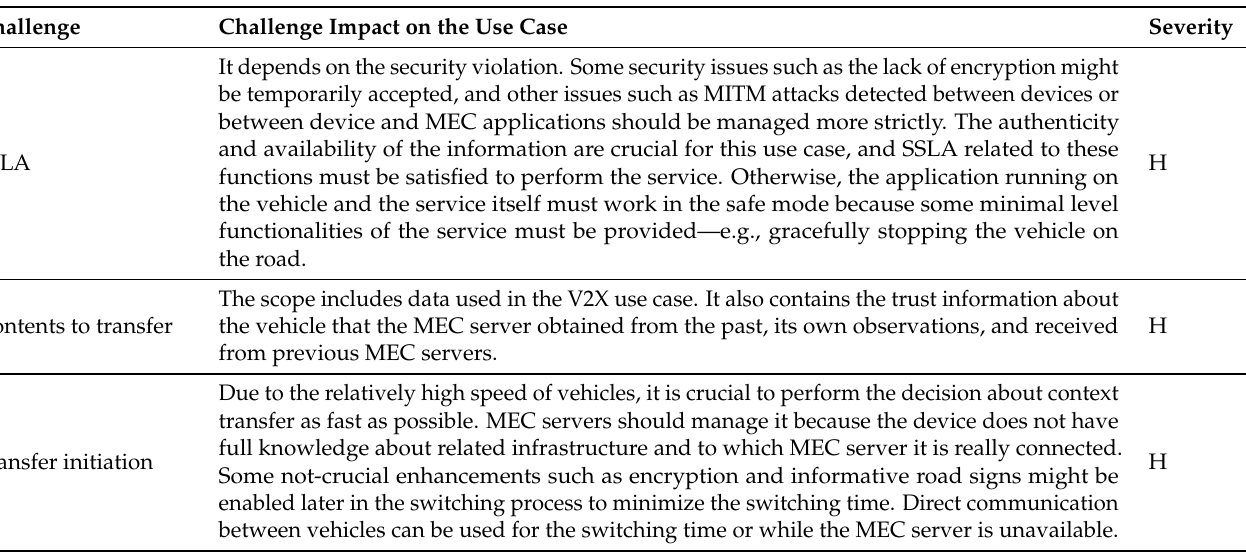
Table 13. Challenges in the automated vehicles use